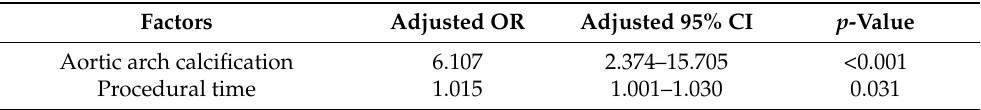
Table 3. Multivariable logistic regression analysis of factors affecting procedural thromboembolism after mechanical thrombectomy for acute ischemic